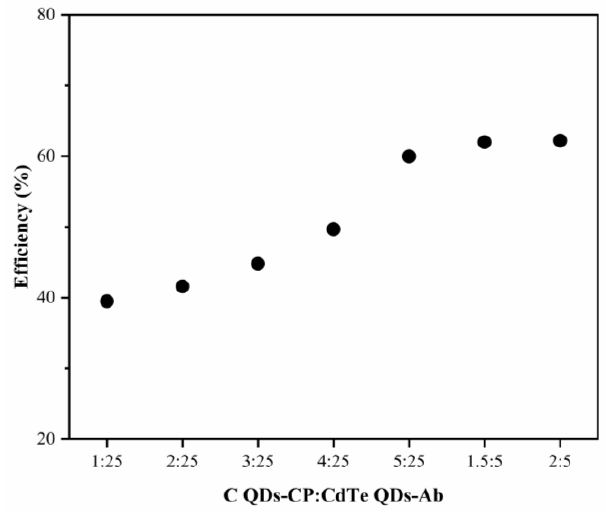
Figure 5. The effect of the proportion of CdTe QDs-Ab and C QDs-CP on the quenching efficiency